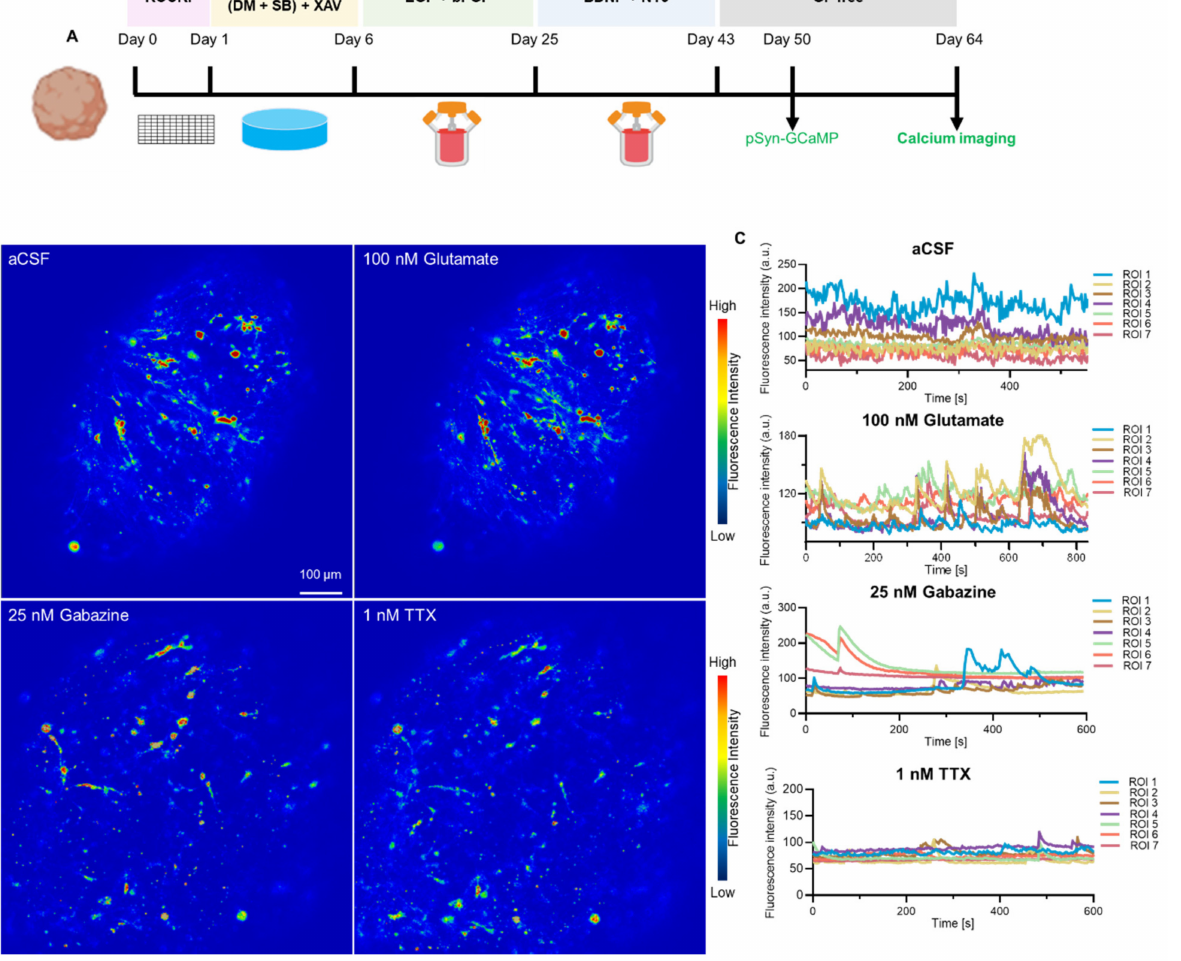
Figure 4. Normal neuronal network activity in human cortical organoid. ( A ) Protocol used to analyse AAV-mediated calcium indicator GCaMP expression under human Synapsin promoter. GCaMP AAV was added to cortical organoid at day 50 and measured after 14 days. ( B ) Heat maps of maximum fluorescence intensity of control aCSF, glutamate, gabazine, and TTX-treated cortical organoid. Scale bar is 100 µ m. ( C ) Calcium traces of individual neurons were measured for each treatment ( n =